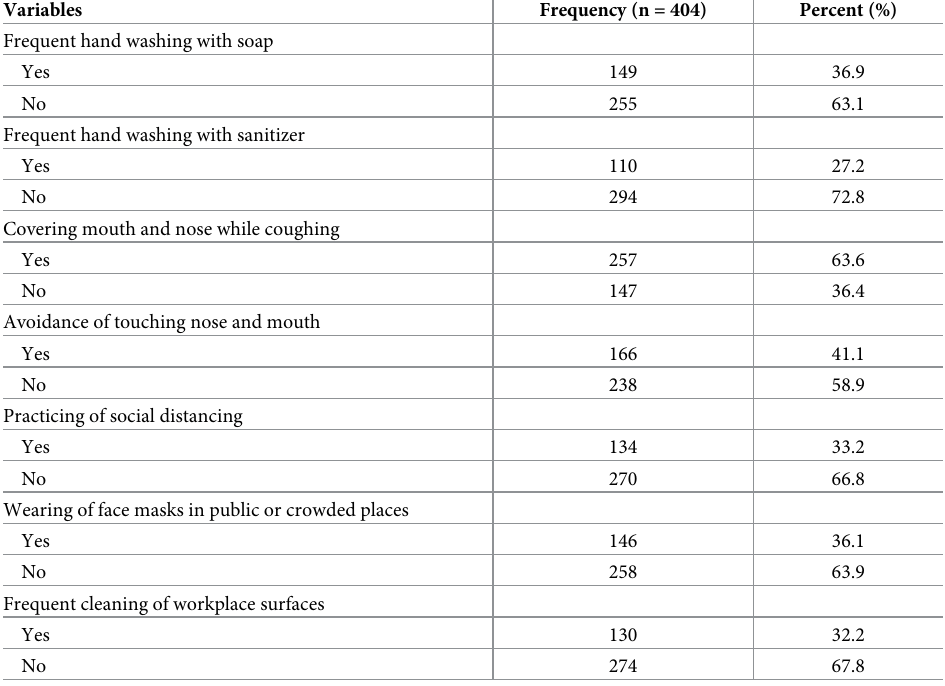
Table 6. Practices of the respondents about COVID-19 (n =